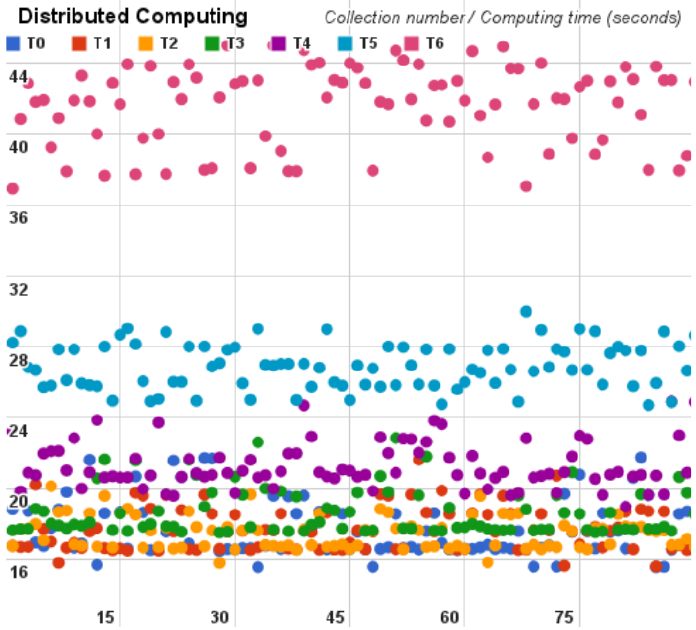
Figure 8. Distributed architecture as a dispersion